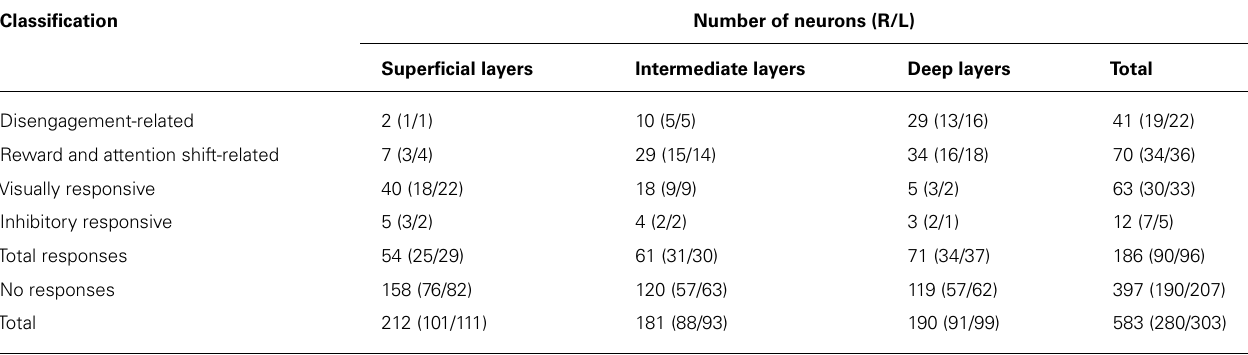
Table 1 | Classification and numbers of the SC neurons. Classification Number of neurons (R/L) Superficial